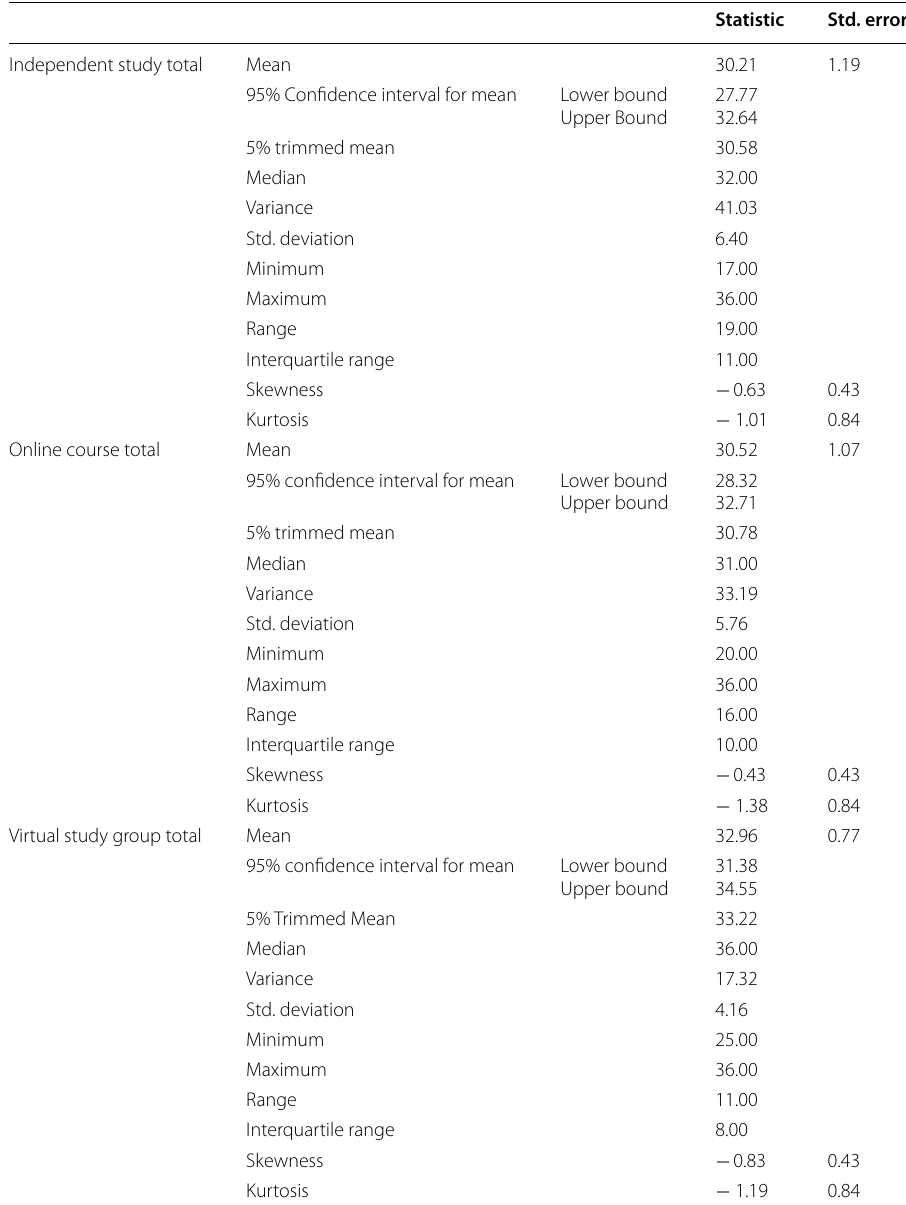
Table 2 Descriptive statistics